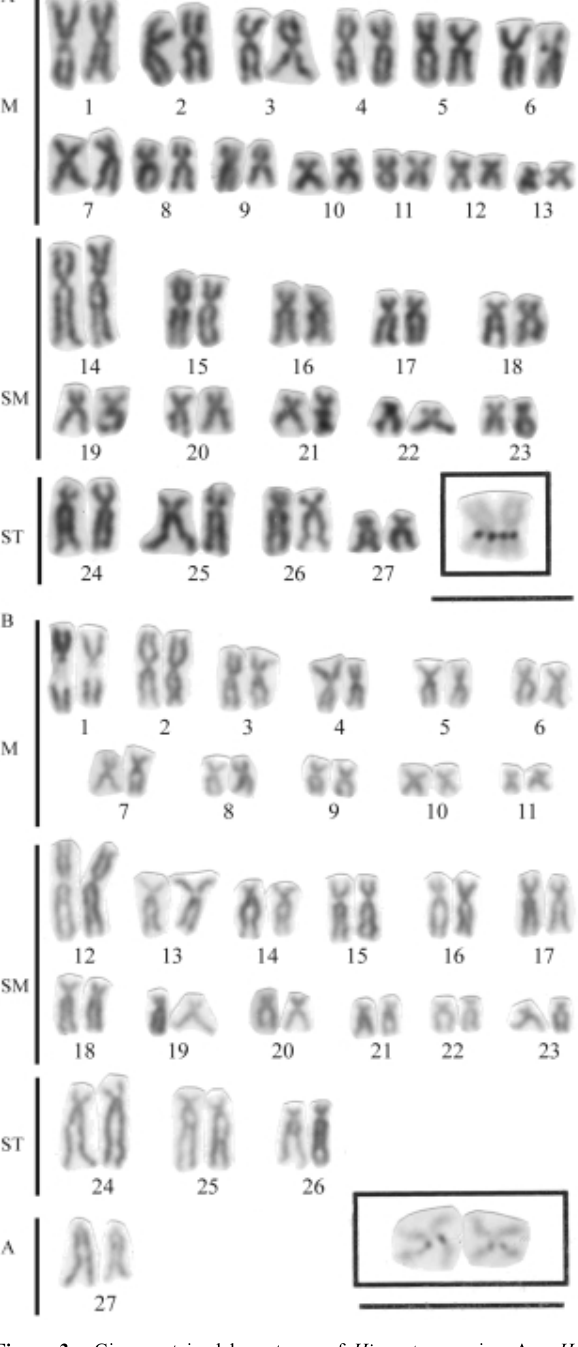
Figure 3 - Giemsa stained karyotypes of Hisonotus species. A = H. nigricauda from Eldorado do Sul (Rio Grande do Sul State); B = H. leucofrenatus from Jaraguá do Sul (Santa Catarina State). Inset, the Ag- NORs-carrier pairs. Bars = 10 (cid:1) m.